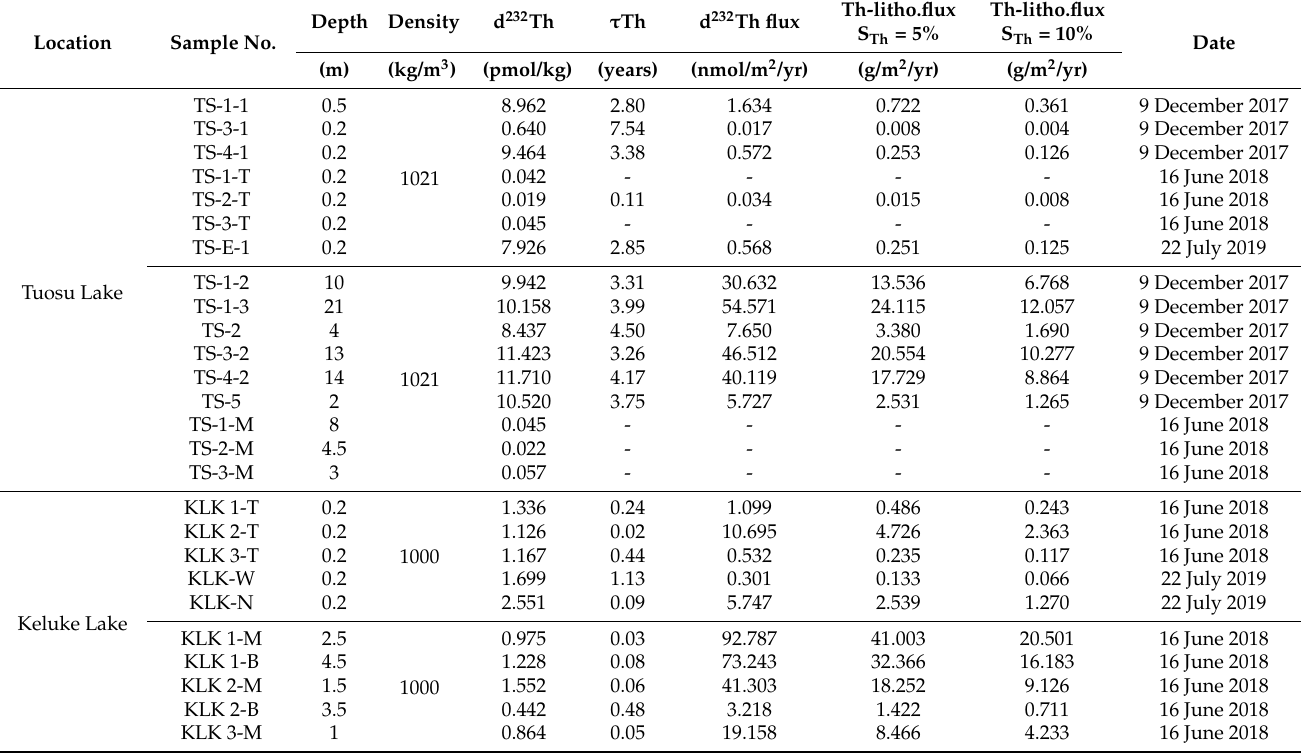
Table 4. The dissolved 232 Th concentration, τ Th, dissolved 232 Th flux, and lithogenic flux in Tuosu Lake and Keluke